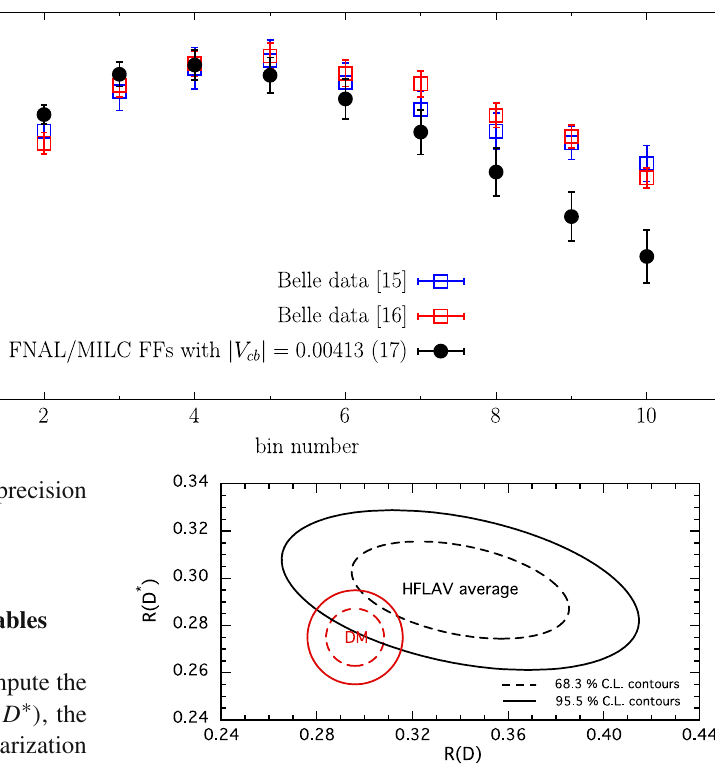
Fig. 5 The contour plots of the DM results for the ratios R ( D ) and R ( D ∗ ) , obtained respectively in Ref. [3] and in this work, compared with those corresponding to the experimental world averages from HFLAV